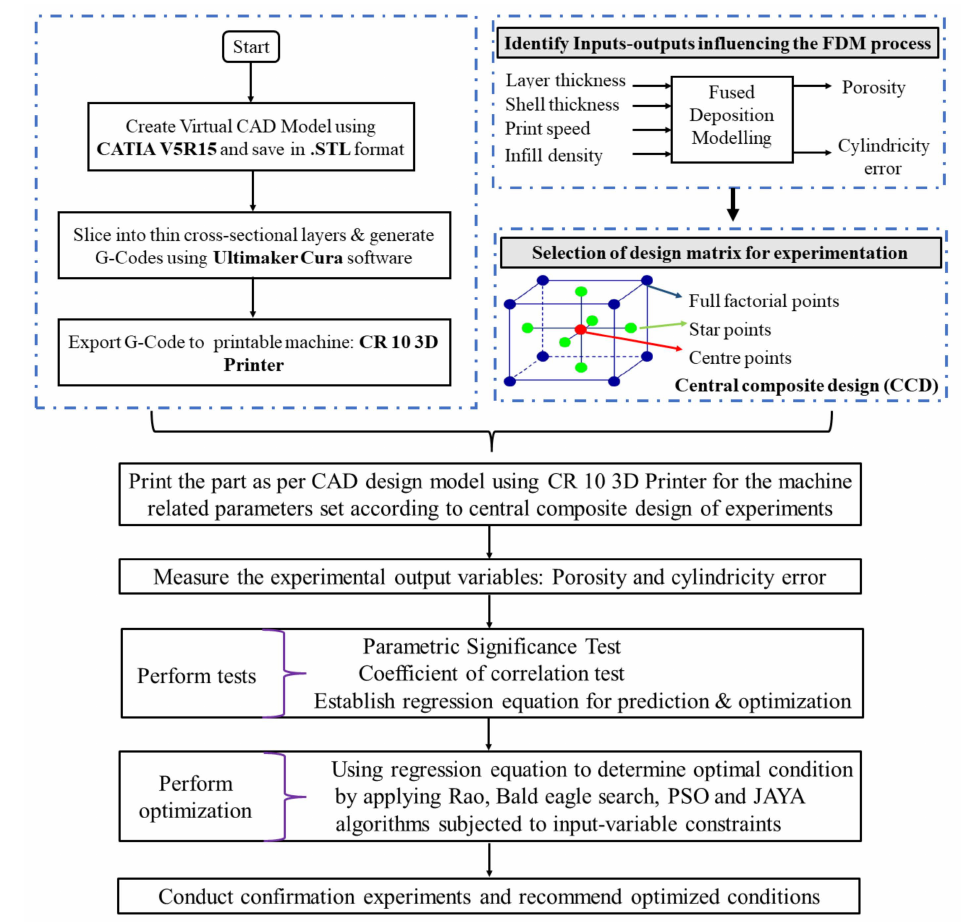
Figure 3. The framework of proposed research work on modelling and